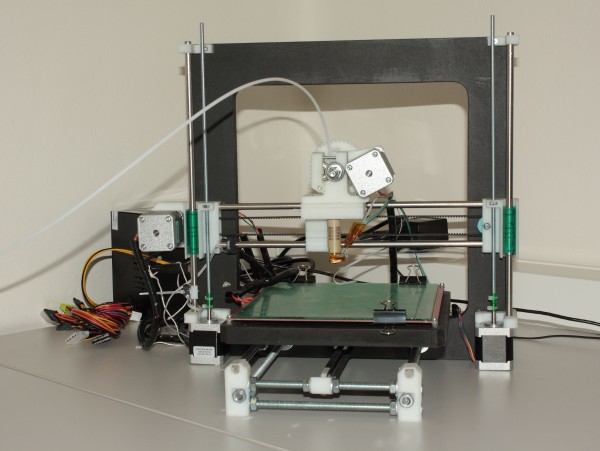
RepRap 3D printer.